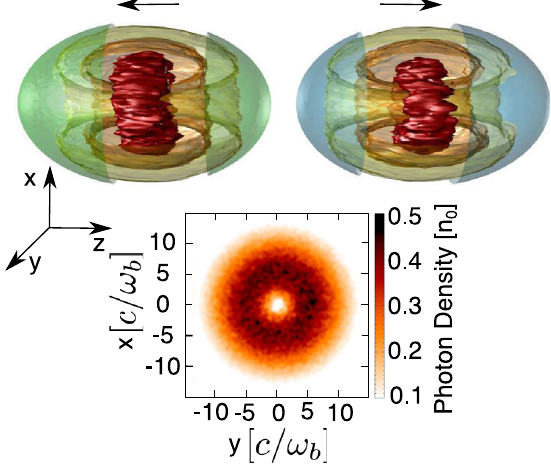
(×).FIG. 1. The produced photon beam is represented by different iso-surfaces of the photon density [ n ω ¼ 0 . 35 ; 0 . 5 ; 0 . 65 ð n 0 Þ ] (yellow, orange, and red, respectively). The photon density is zero on axis, where the collective field vanishes, and it is maximum for R ∼ 5 c = ω . The positron beam is shown in green, b and the electron beam in blue.